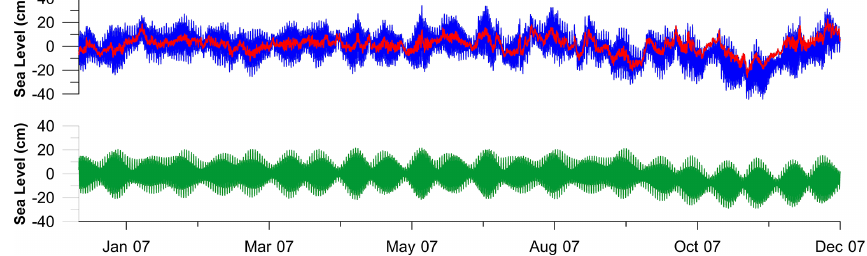
Figure 8. Example of recording collected during the year 2007 at NAPT tide gauge, located in the port of Naples: recorded sea level change (blue line), synthetic signal (green line) retrieved from the assessed tidal constants (amplitude and phase) of the seven main components, and residual signal (red line) with respect to the synthetic one.